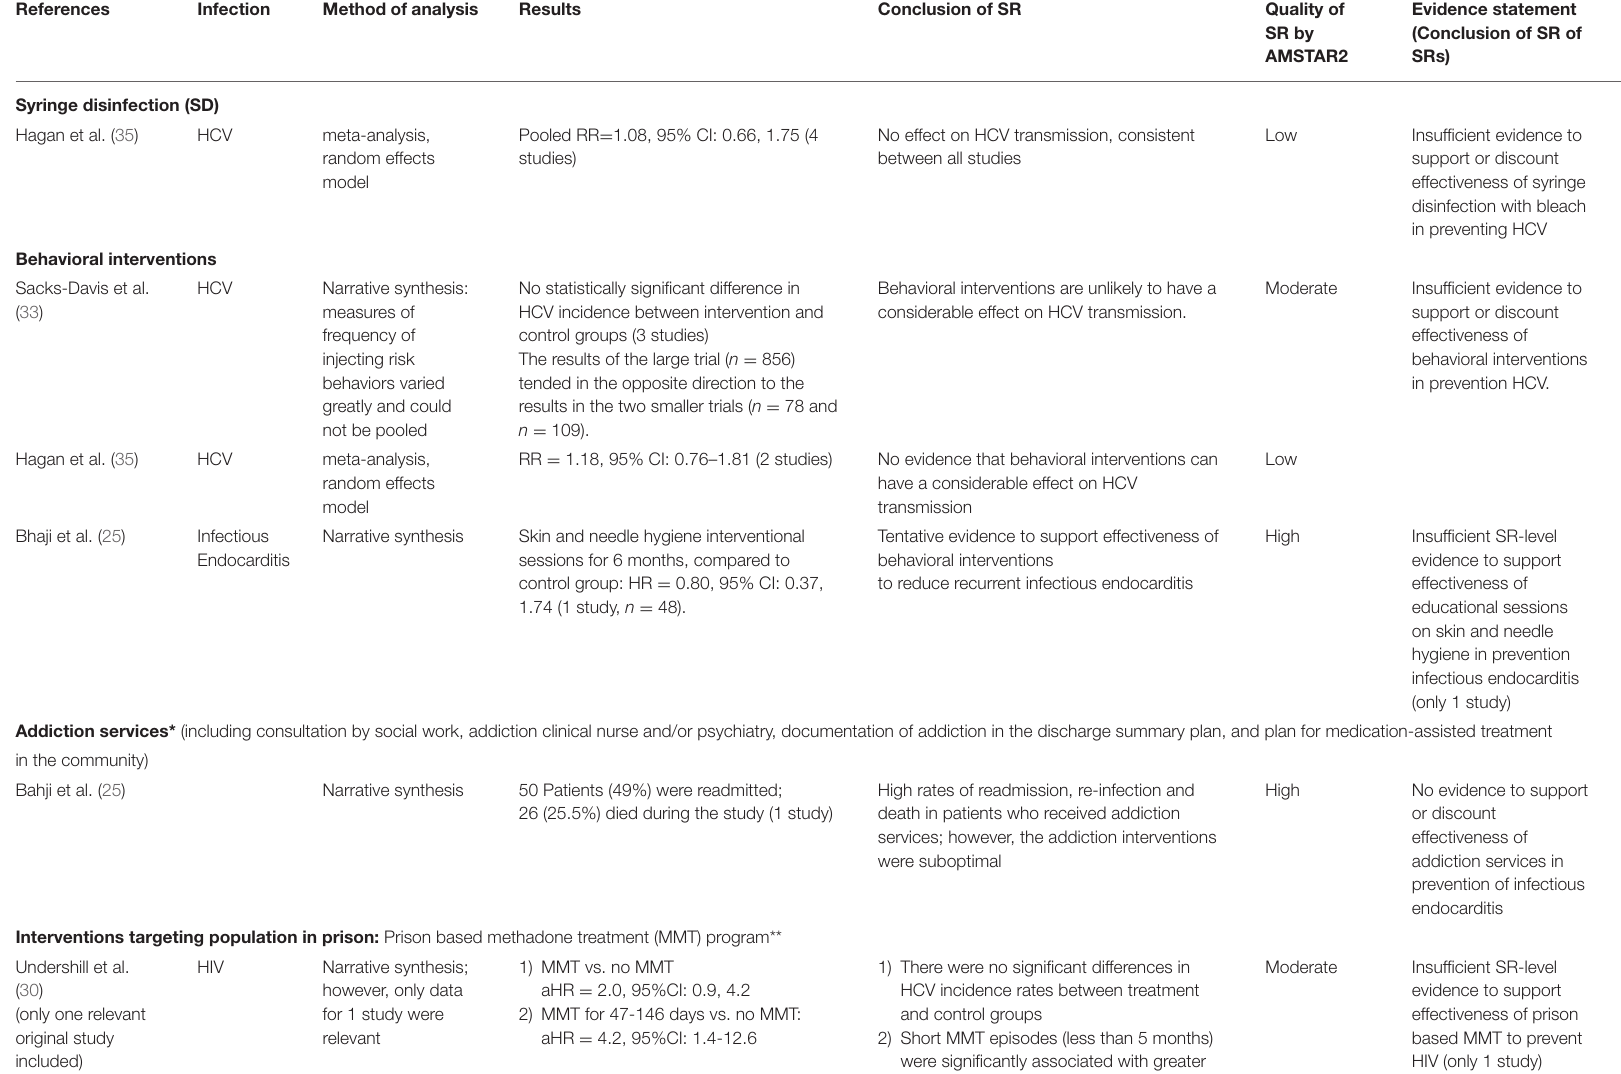
TABLE 6 | Summary of results of systematic reviews evaluating effectiveness of other interventions to prevent infections in opioid